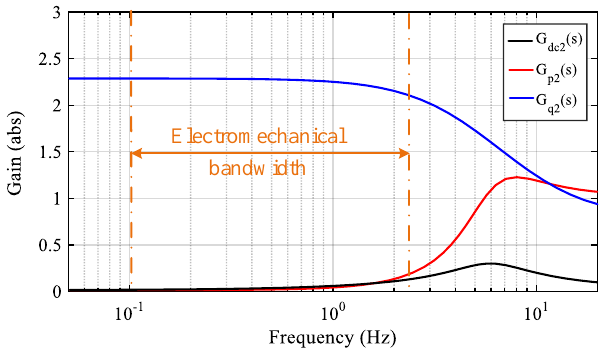
Figure 4. Bode gain diagram of the transfer function matrix.